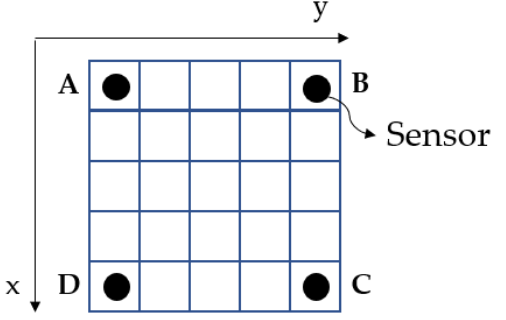
Figure 1. Thin plate model with the sensors and the impact localization areas. Letters A, B, C, D correspond to the respective sensors, as they are denoted later in the paper as SensorA, SensorB, etc. The set of the squares is denoted as Q = { q 1,1 , q 1,2 , . . . , q 1,5 , q 2,1 , q 2,2 , . . . , q 2,5 , q 3,1 , . . . , q 5,1 , . . . , q 5,5 } where x and y at q x , y is the row and column square, respectively,